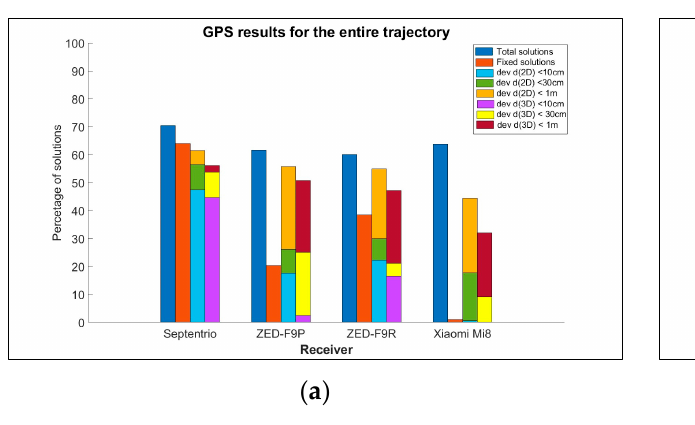
Figure 8. Entire trajectory (static and kinematic): ( a ) GPS solutions; ( b ) GNSS solutions. Each bar in a group shows: available solutions (1st bar), percentage of fixed solutions (2nd bar), deviation at horizontal distances (3rd bar, where light blue is for thresholds less than 10 cm, green is for thresholds less than 30 cm, and brown is for thresholds less than 1 m), and 4th bar shows deviation at spatial distances (yellow, green, and dark red for 10 cm, 30 cm, and 1 m thresholds, respectively).